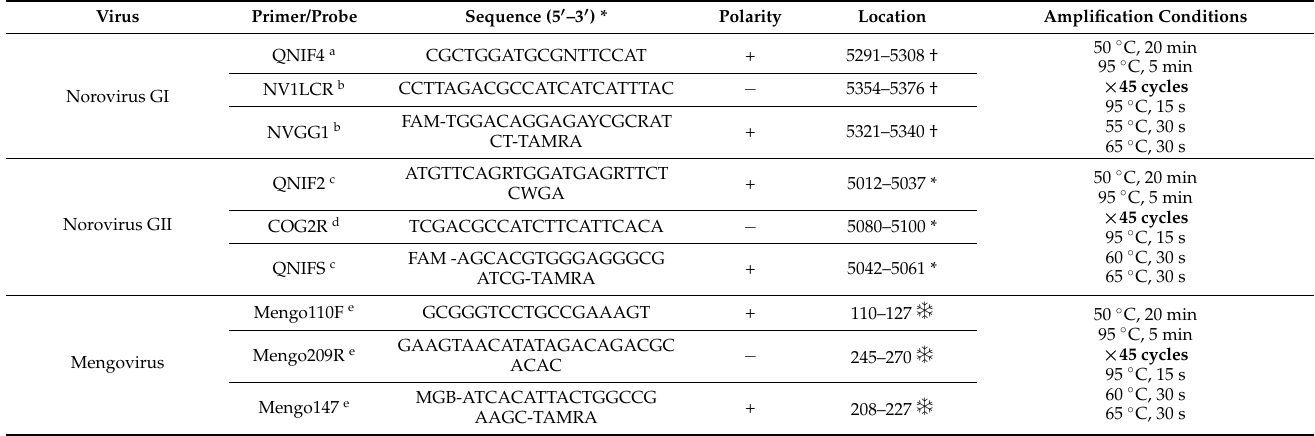
Table 1. Real-time RT-PCR and typing PCR assay primers and probes.